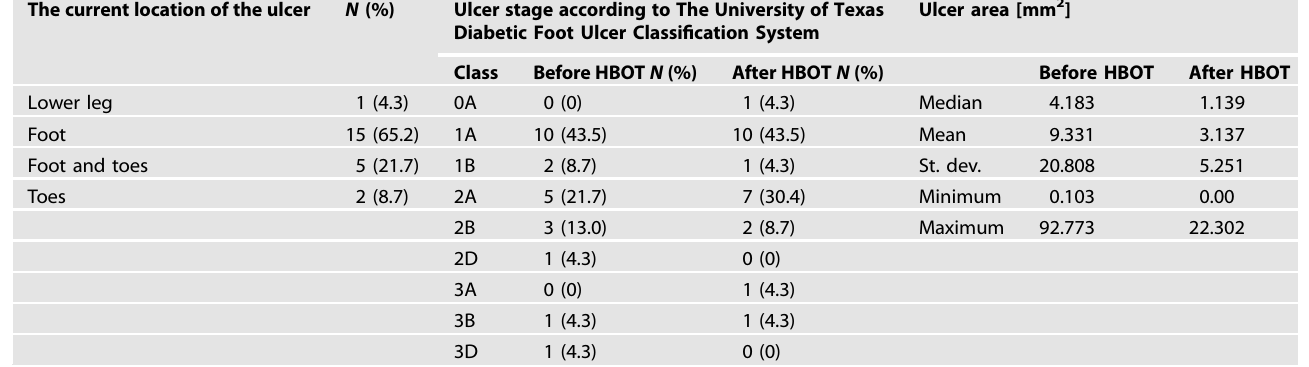
Ulcer area [mm 2 ]